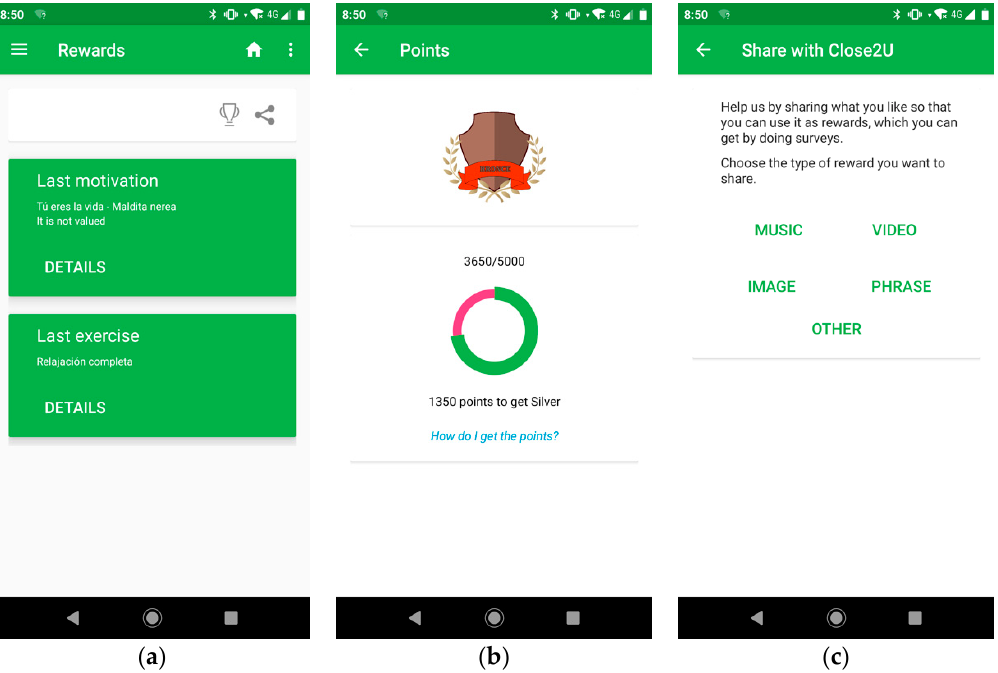
Figure 4. Screens of the user interface: ( a ) Rewards screen, ( b ) Points screen and ( c ) Share screen.